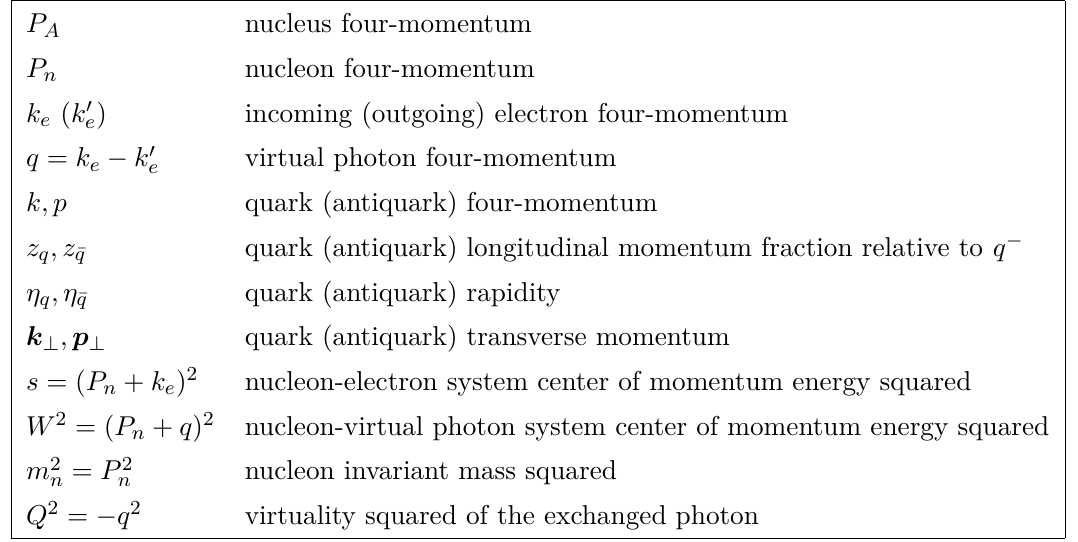
Table 1 . Kinematic